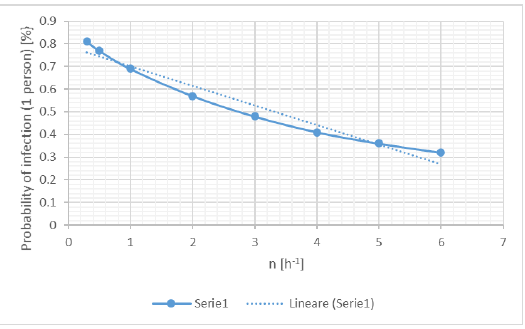
Figure 13. Probability of infection with 1 infected person in an average classroom compared to ventilation rate.